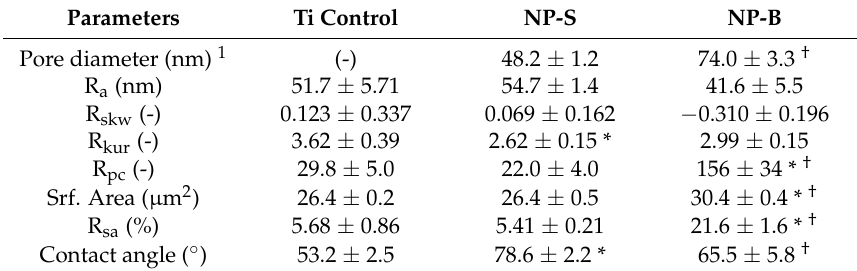
Table 1. Summary of TiO 2 nanoporous and Ti control surface